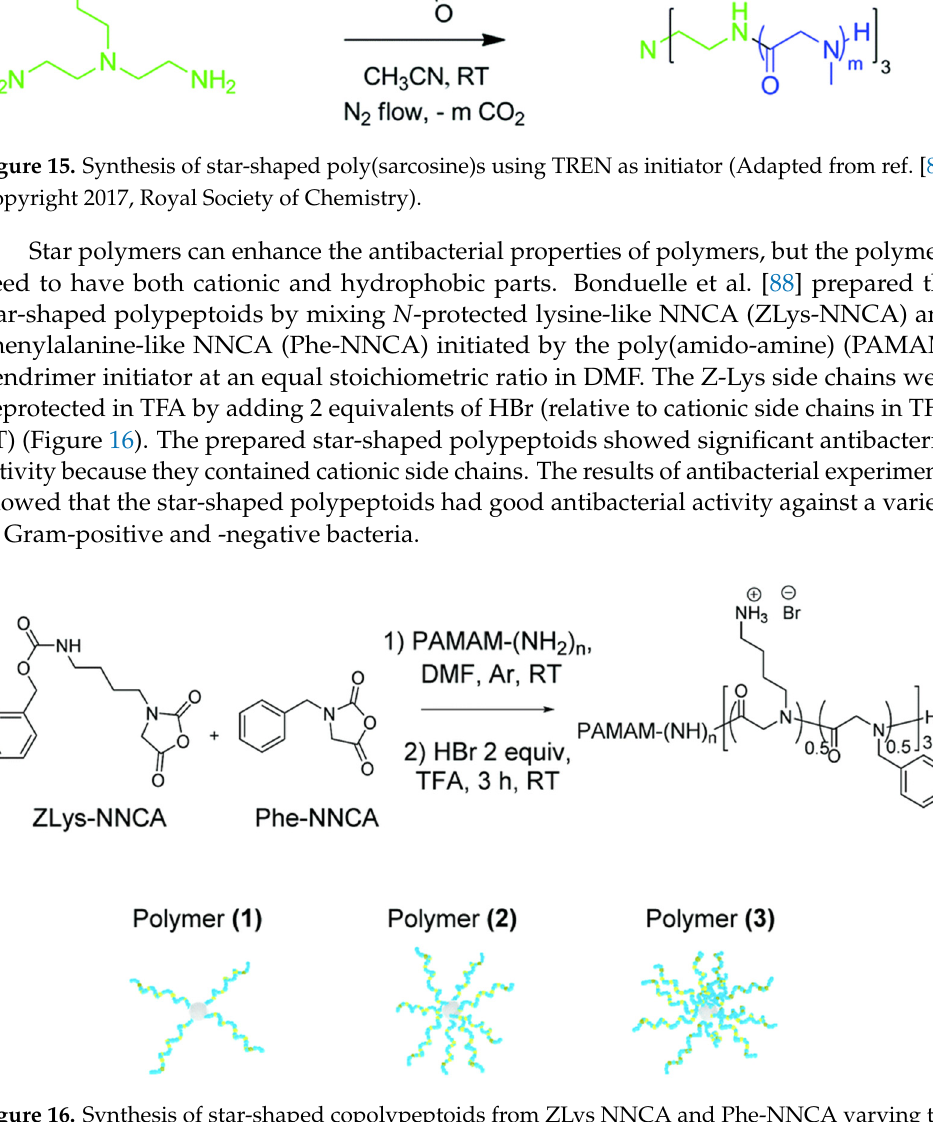
Figure 16. Synthesis of star-shaped copolypeptoids from ZLys NNCA and Phe-NNCA varying the hydrophobic content (Adapted from ref. [88]. Copyright 2022, Royal Society of Chemistry).